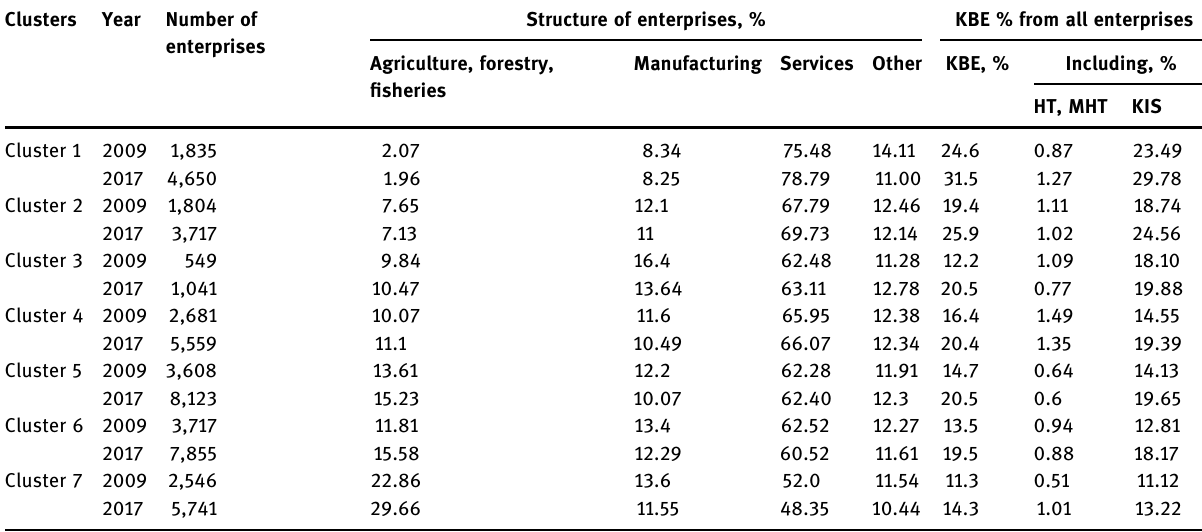
Table 2: Structural changes of enterprises in the clusters, 2009 – 2017 Clusters Year Number